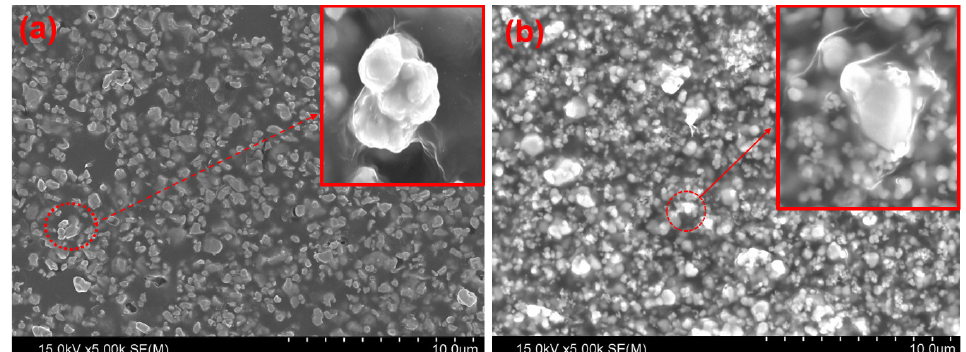
Figure 5. Comparison of the double coating of tungsten particles with respect to the state of the polymer used (emulsion or powder): ( a ) coating caused by mixing of the emulsion polymer; ( b ) double-shell structure produced through the heat treatment of the powder polymer.